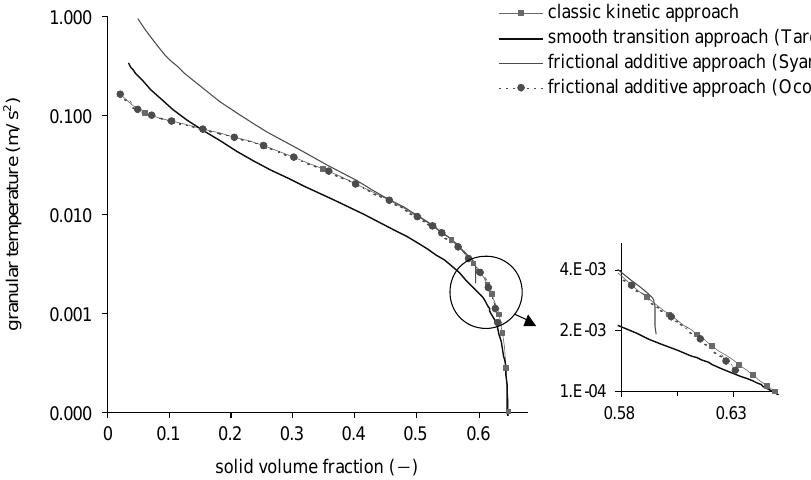
Fig. 11 Variation of granular temperature as a function of concentration predicted by various modelling